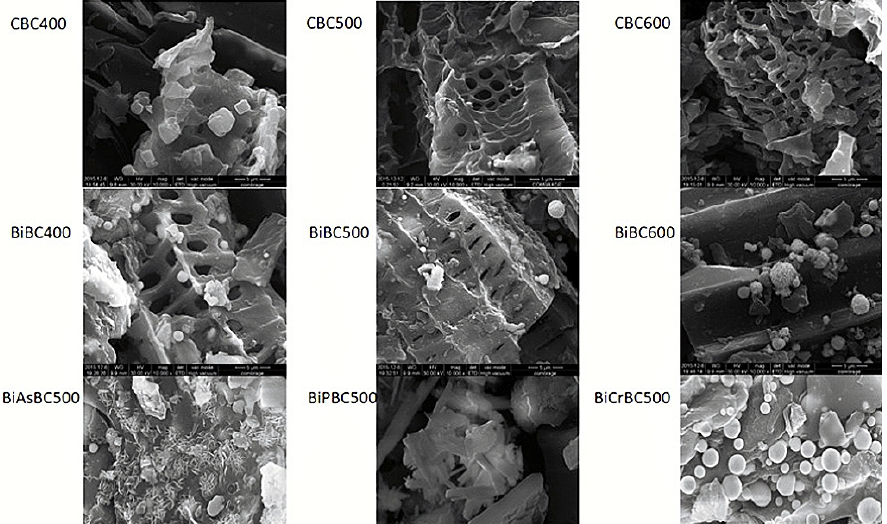
Figure 5. SEM images of wheat straw prepared at various temperatures before and after modification (modified from [107]). Reprinted with permission from Ningyuan Zhu et al. (2016). Copyright 2016, Elsevier.